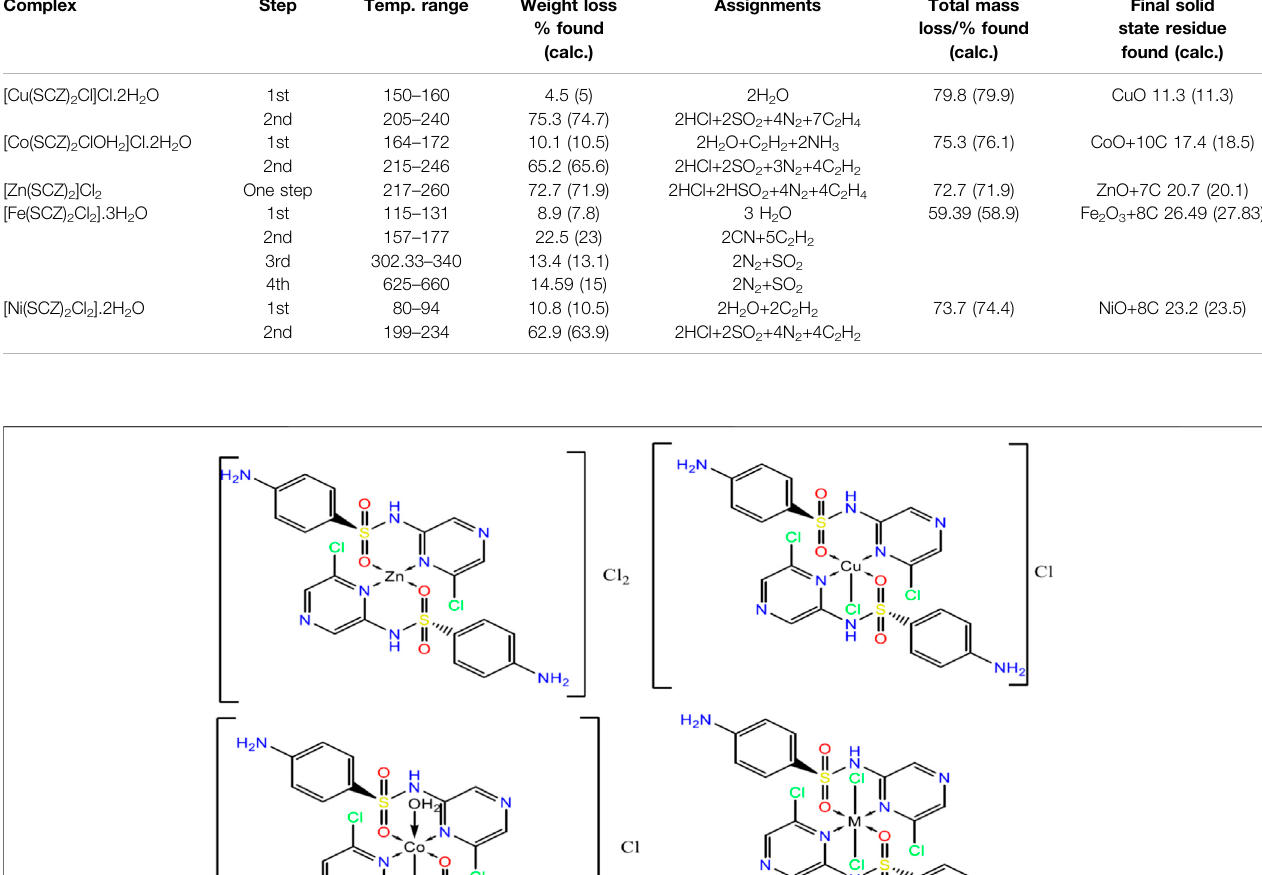
TABLE 3 | Thermogravimetric data of the fi ve metal complexes. Complex Step Temp. range Weight loss